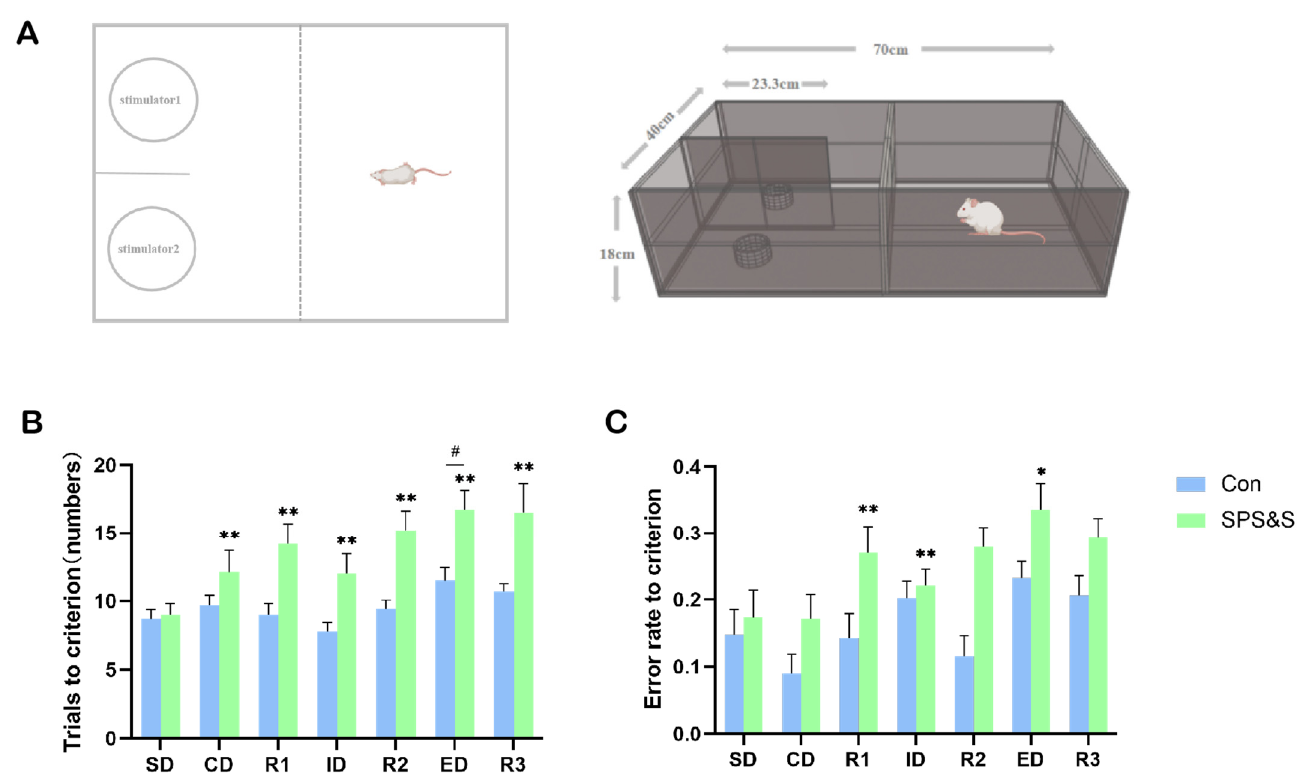
Figure 2. Effects of SPS&S on the performance of the ASST in rats. ASST experimental device ( A ); the number of trials to criterion ( B ), error rate to criterion ( C ). The data are expressed in terms of mean ± SEM. * p < 0.05, ** p < 0.01 compared to SPS&S group on the same stage; # p < 0.05 compared to ID phase on the same group. The rats were required to perform six consecutively correct re- sponses in each stage before moving on to the next stage, from simple discrimination (SD) to com- pound discrimination (CD), reversal 1 (R1), intra-dimensional (ID) shift, reversal 2 (R2), extra-di- mensional (ED) shift, and finally, reversal 3 (R3).